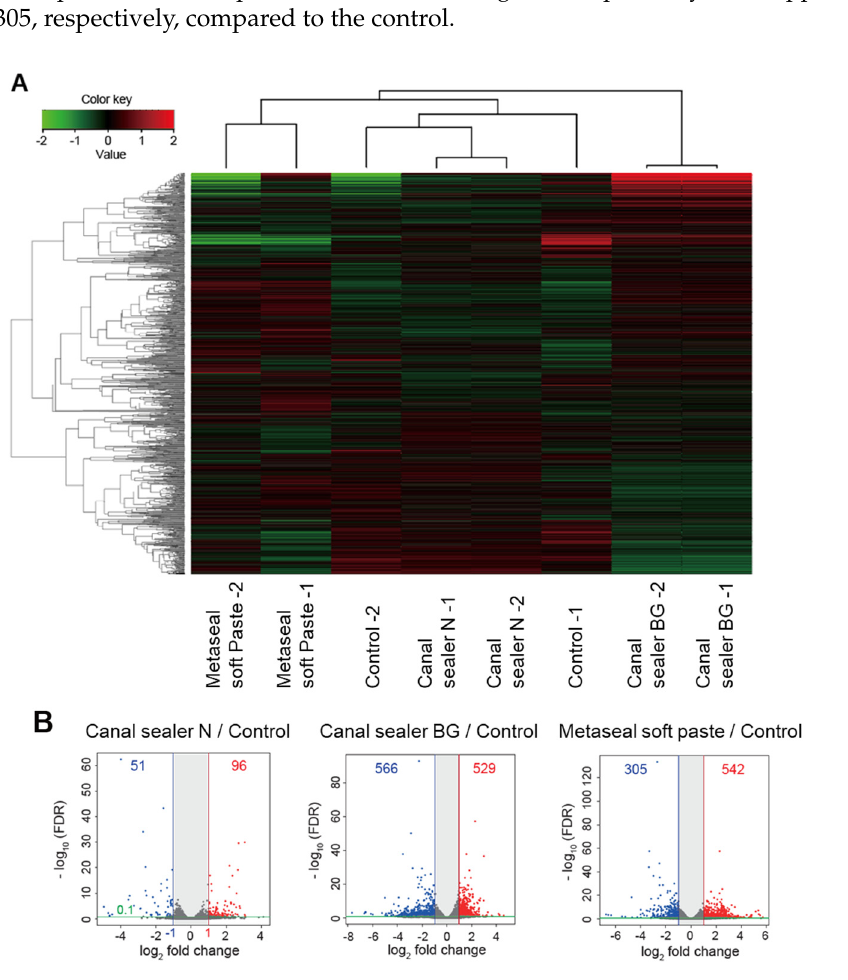
Figure 5. RNA-seq results. Heat map shows the clustering of top 10,000 genes that contribute to the differences in each group ( A ). Each column represents a material and each row a gene. Clustering was performed using iDEP with edgeR log transformation of read counts. Hierarchical clustering was illustrated using the average linkage method with correlation distance. Color-coding was based on edgeR log-transformed read counts. Color key indicates Z-scores, which are dis- played as relative values for all tiles within all samples. Green indicates the lowest level, black an intermediate level, and red the highest level of expression. Volcano plots present the differential expression of genes between the Canal Sealer N, Canal Sealer BG, or Metaseal soft paste groups and the control group ( B ). The plots show differences in gene expression under the conditions indicated in each figure. Colored circles indicate significantly upregulated (red) and downregulated (blue) genes (absolute log2 fold change > 1; adjusted p <